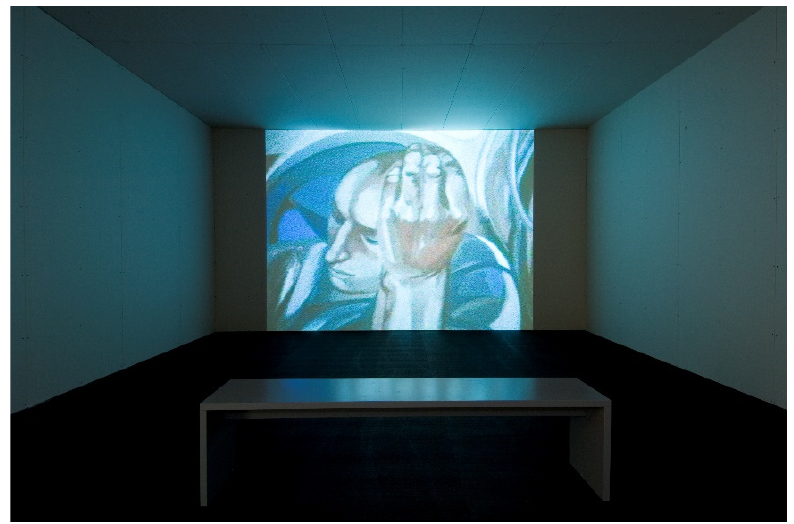
Figure 15. Room view of the presentation ‘Plug In #06: El Lissitzky, Deimantas Narkevicius’, Van Abbemuseum 2006. Still from the film ‘Energy Lithuania’ by Deimantas Narkevicius, 2006. Photo: Peter Cox.